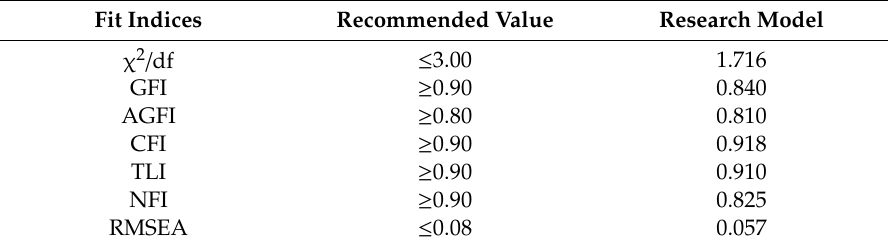
Table 5. Model fit (Source: Authors’